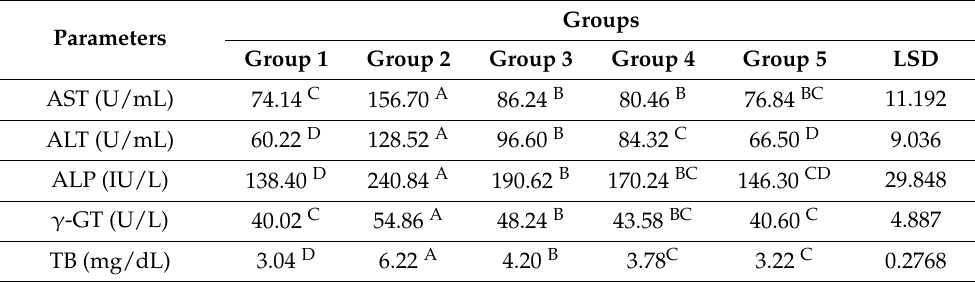
Table 5. Effect of a yogurt drink fortified with golden berry juice on serum ALT, AST, ALP, and γ -GT activities in rats with